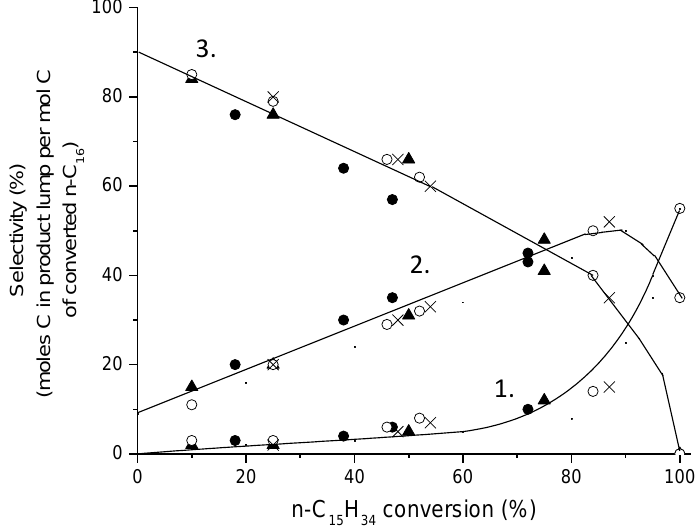
Figure 2. Selectivities of 1 . monobranched, 2 . dibranched, and 3 . cracking products as a function of hexadecane conversion at 310 °C under 30 bar over different Pd-SiO 2 -Al 2 O 3 catalysts adapted from [18]. Reproduced with permission from Regali et al., Catal. Today ; published by Elsevier, 2014 .